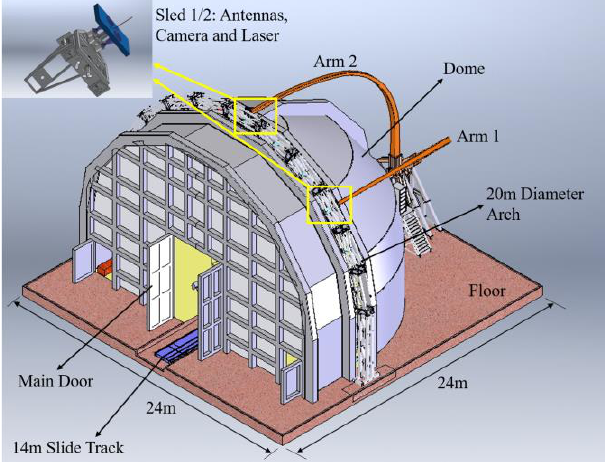
Figure 1. Overall view of the LAMP experimental platform.